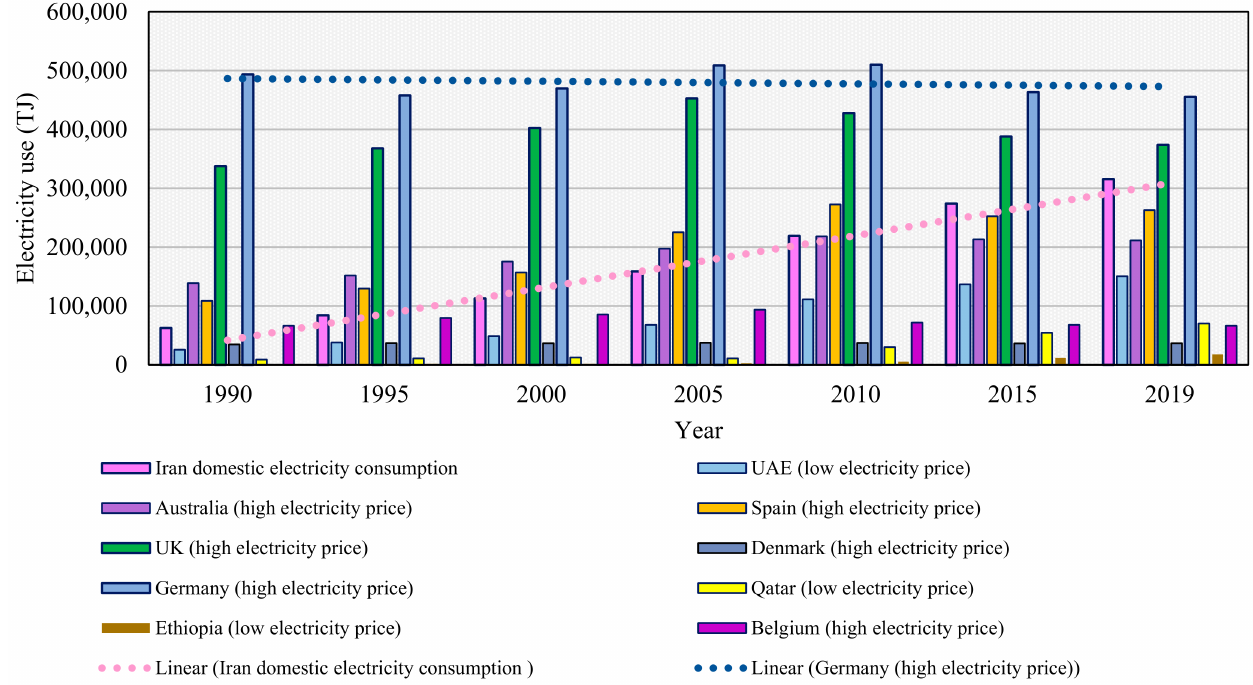
Figure 16. The trend in domestic electricity consumption of low and high electricity price